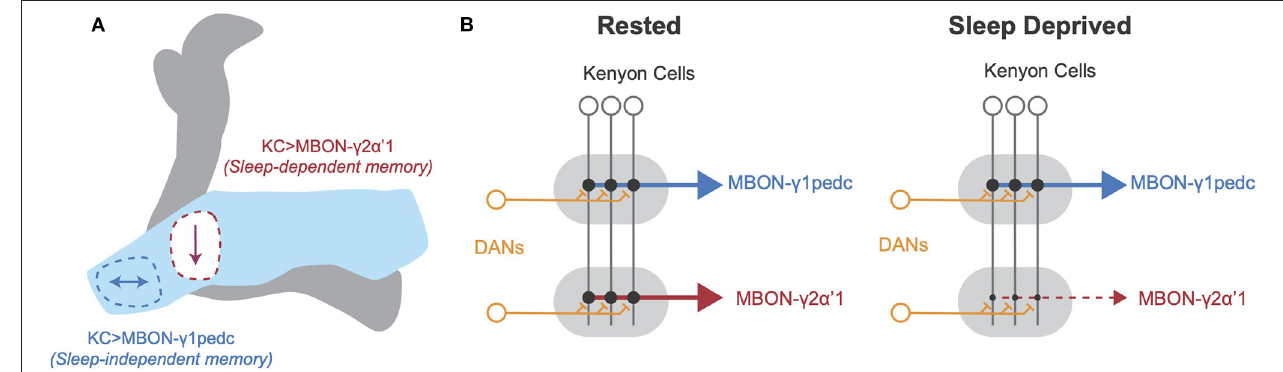
FIGURE 1 | Schematic of local plasticity in Drosophila mushroom body after sleep loss. (A) Schematic illustration of Drosophila mushroom body. The γ lobe (light blue) contains the γ 1 compartment, outlined in blue, and the γ 2 compartment, outlined in red. Arrows represent changes in connectivity from Kenyon cells to MBON- γ 1pedc (left, blue) and MBON- γ 2 α ’1 (right, red). Appetitive memory encoded at KC > MBON- γ 1pedc synapses is resilient to sleep loss, but appetitive memory encoded at KC > MBON- γ 2 α ’1 synapses is impaired by sleep loss. (B) Schematic of connectivity between neuronal cell types in MB in rested (left) and sleep deprived brains (right). KC axons innervate tiled zones that each receive input from distinct DANs and provide input to unique MBONs. After SD, KC > MBON- γ 1pedc connectivity is unchanged, but KC > MBON- γ 2 α ’1 connectivity decreases. Based on findings from Weiss and Donlea (2021) and Chouhan et al.